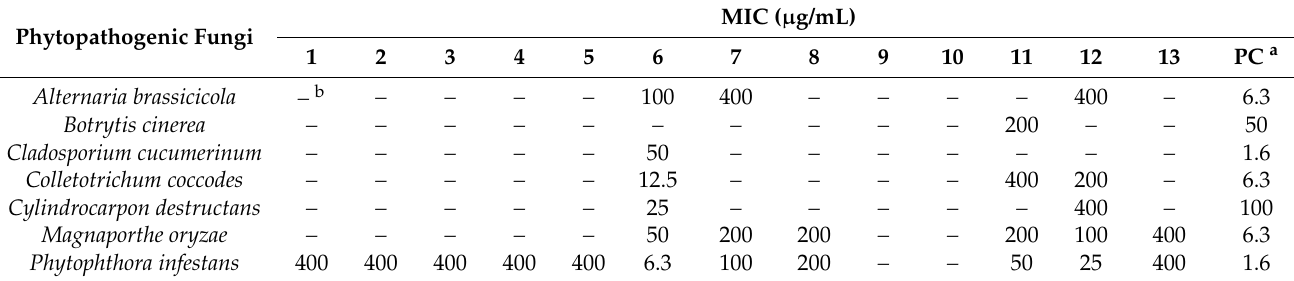
except for B. cinerea (Table 3). Table 3. In vitro antifungal activity of compounds 1 – 13 against phytopathogenic